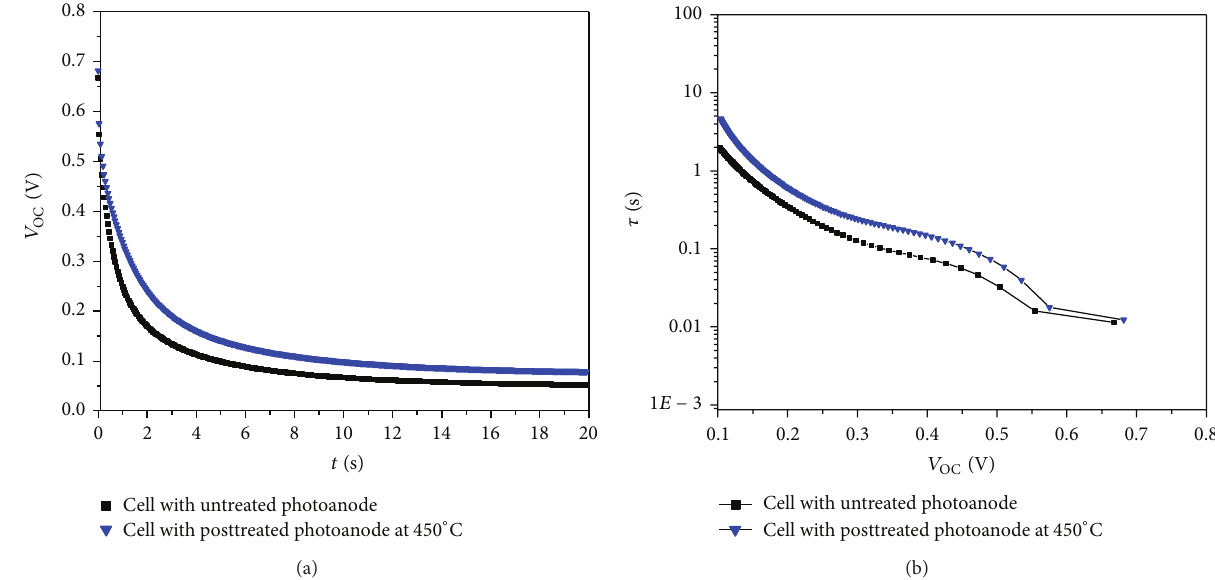
Figure 6: (a) Open circuit voltage decay curves; (b) electron lifetime as a function of the 𝑉 square) and posttreated photoanode with colloidal treatment at 450 ∘ C (blue full inverted